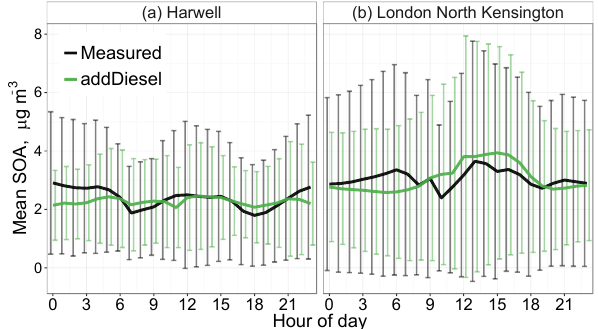
Figure 9. Average hourly profiles of modelled (addDiesel experi- ment) and measured SOA during the summer IOP. Also shown are the standard deviations for each mean